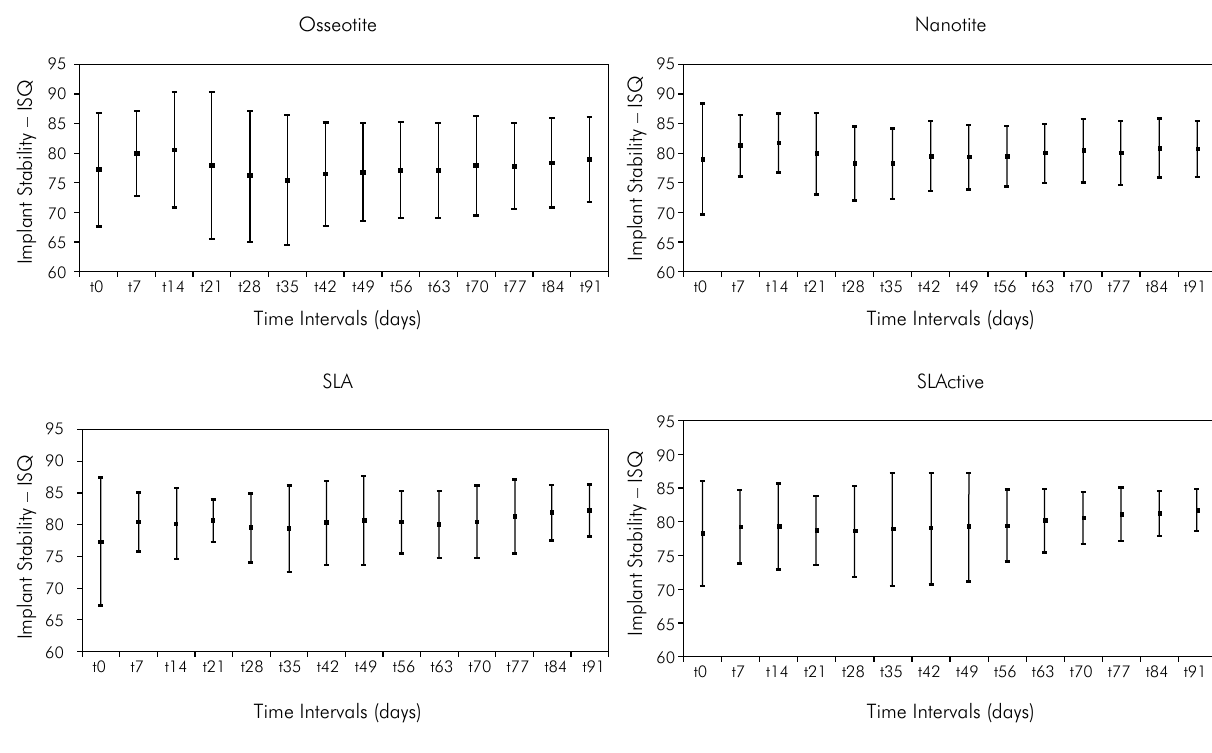
Figure 4. Range of Implant stability values (Mean, upper, and lower interval) as a function of time according to the implant types.